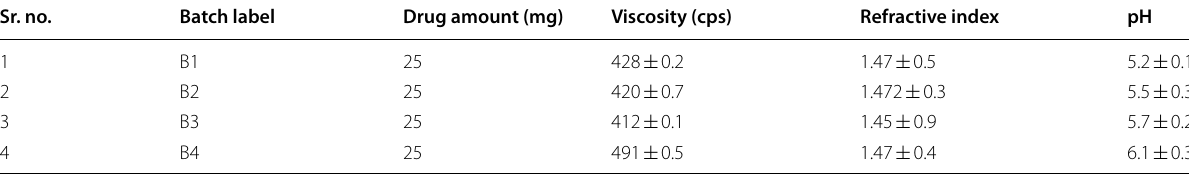
Table 4 Physicochemical parameters of developed tenofovir nanoemulsion Sr. no.